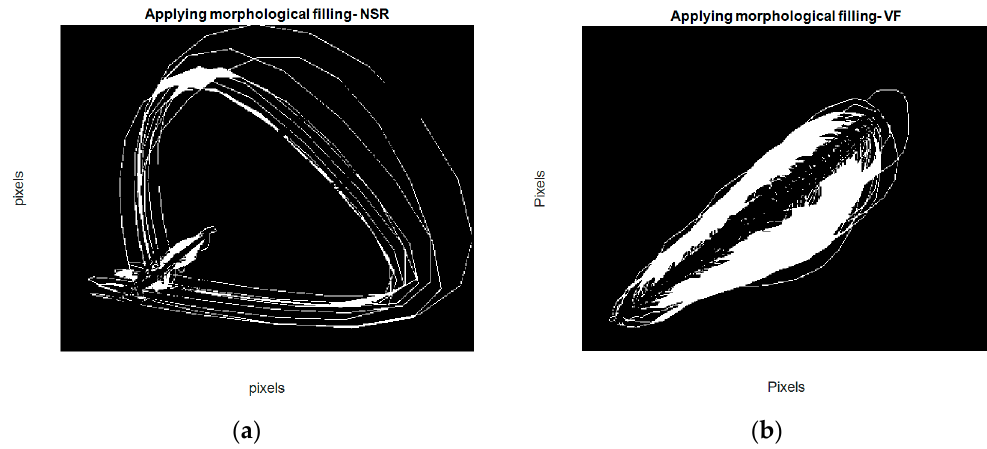
Figure 7. Resulting images for acquisition of the fourth feature ( a ) for an NSR segment ( b ) for a VF segment.